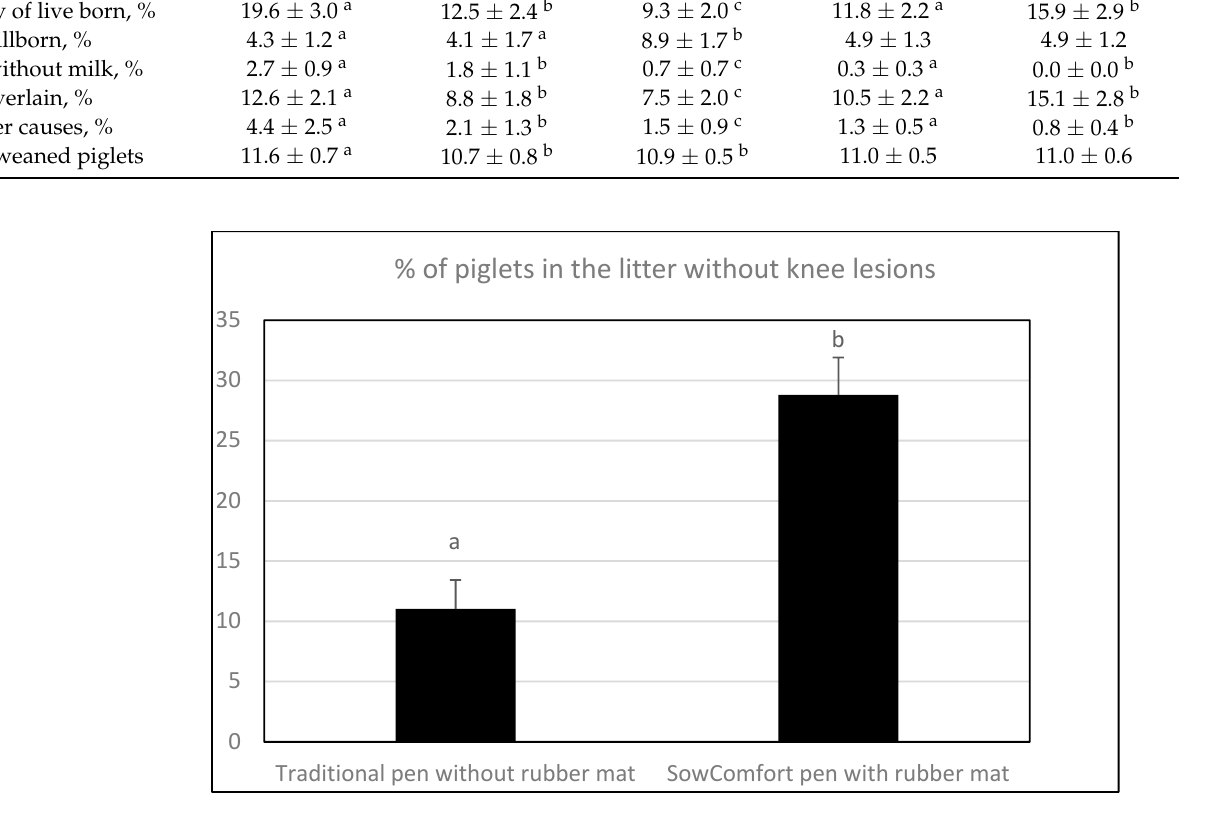
Figure 6. Percentage of piglets in each litter (means + SE) that did not have any carpal joint lesions on day 2 post-partum in farm 1 (n = 119 litters). Significant differences between bars are denoted by different superscripts, a and b.